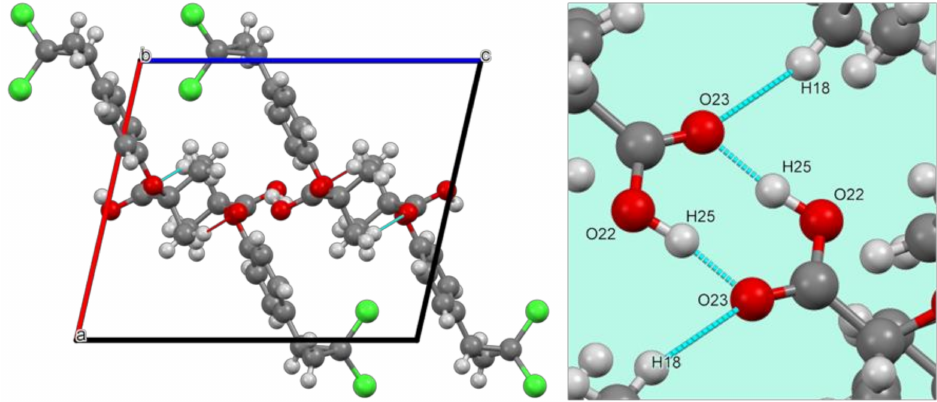
Figure 4. CIP’s crystal structure forms a network of molecular aggregates along the b-axis, with four formula units per unit cell (Z = 4). Hydrogen bonds (cyan lines) are shown on the right side in an enlarged region of the unit cell. Atom color code: red = oxygen (O); green = chloride (Cl), grey = carbon (C); light grey = hydrogen